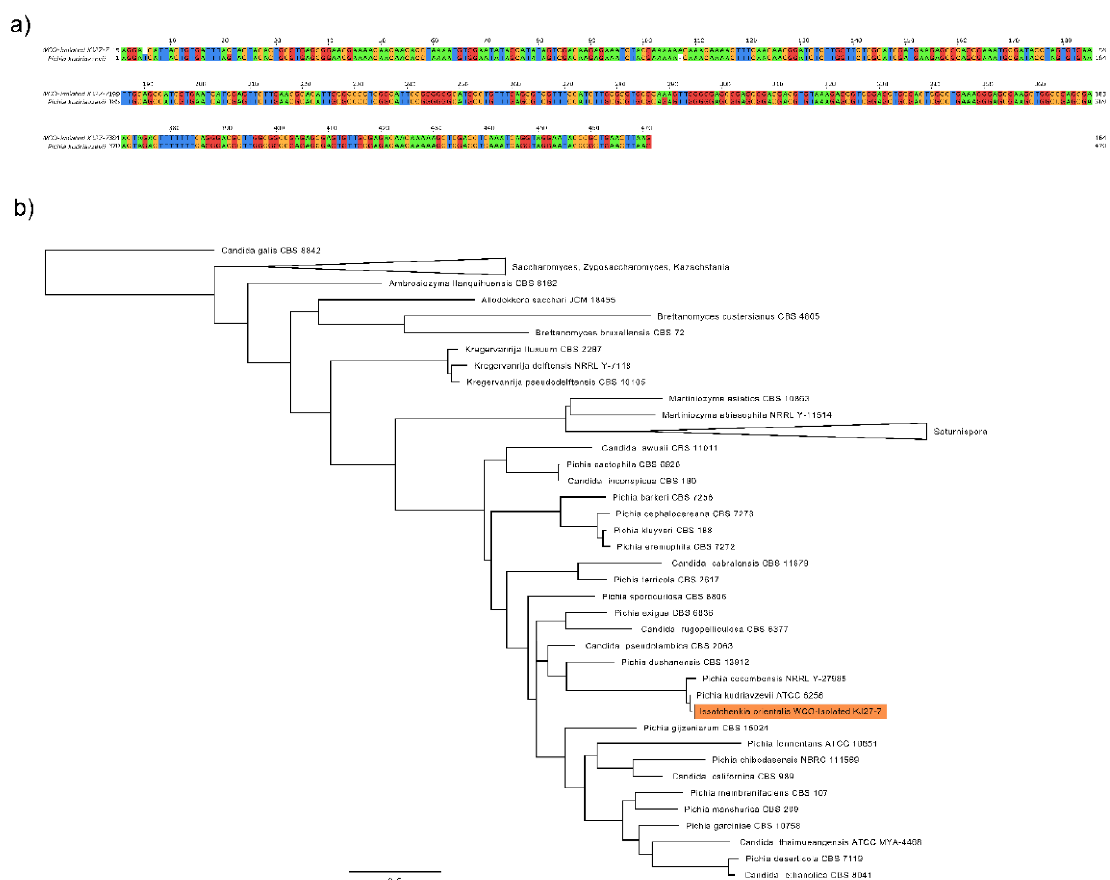
Figure 1. Isolation of I. orientalis from WCO. ( a ) Pairwise sequence alignment of WCO-isolated I. orientalis KJ27-7 and Pichia kudriavzevii ATCC 6258. Alignment of 470 bp region of the ITS region of the genome. Nucleotides are colored (A = green, G = red, T = blue, C = yellow) to display mismatching sites. ( b ) Maximum likelihood phylogenetic tree of WCO-isolated I. orientalis KJ27-7 and closest representative sequences. ITS sequence of WCO isolate is highlighted in orange within a clade of Pichia spp. The tree is rooted with Candida galis .